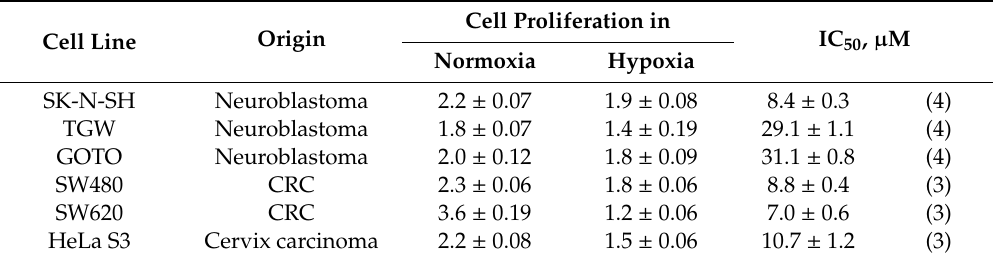
Table 1. Inhibitory e ff ect of LicA on hypoxic cell growth of human cancer cell lines derived from various